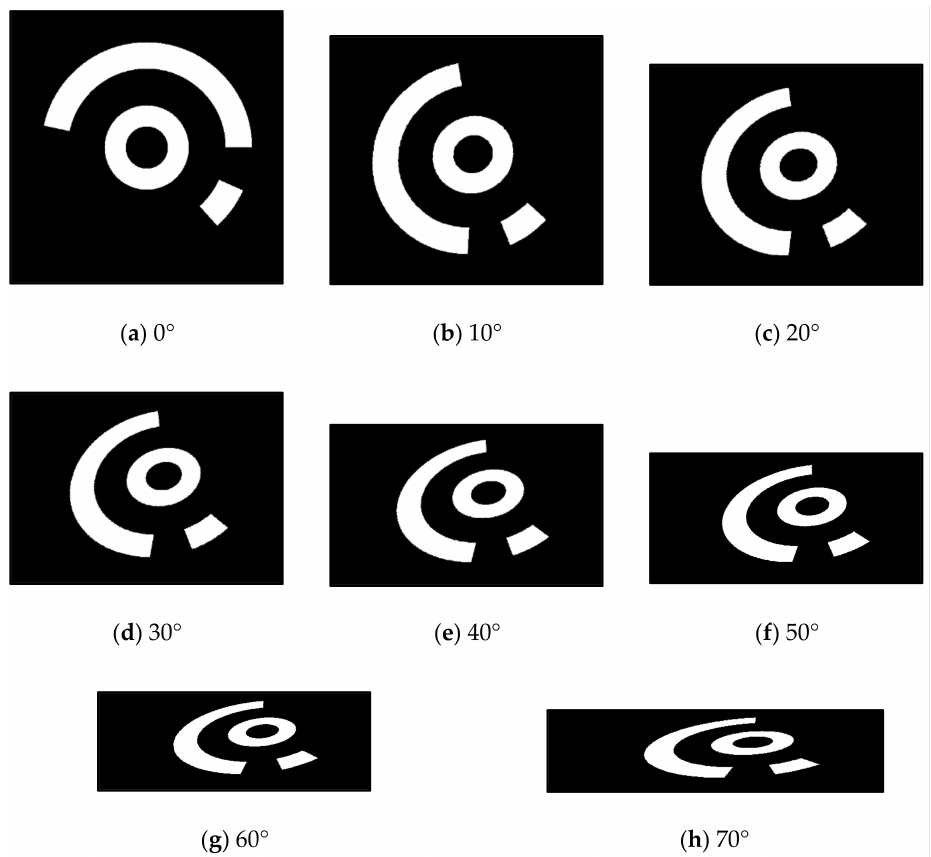
Figure 12. Simulation images with different viewing angles: ( a ) 0 ◦ ; ( b ) 10 ◦ ; ( c ) 20 ◦ ; ( d ) 30 ◦ ; ( e ) 40 ◦ ; ( f ) 50 ◦ ; ( g ) 60 ◦ ; ( h ) 70 ◦